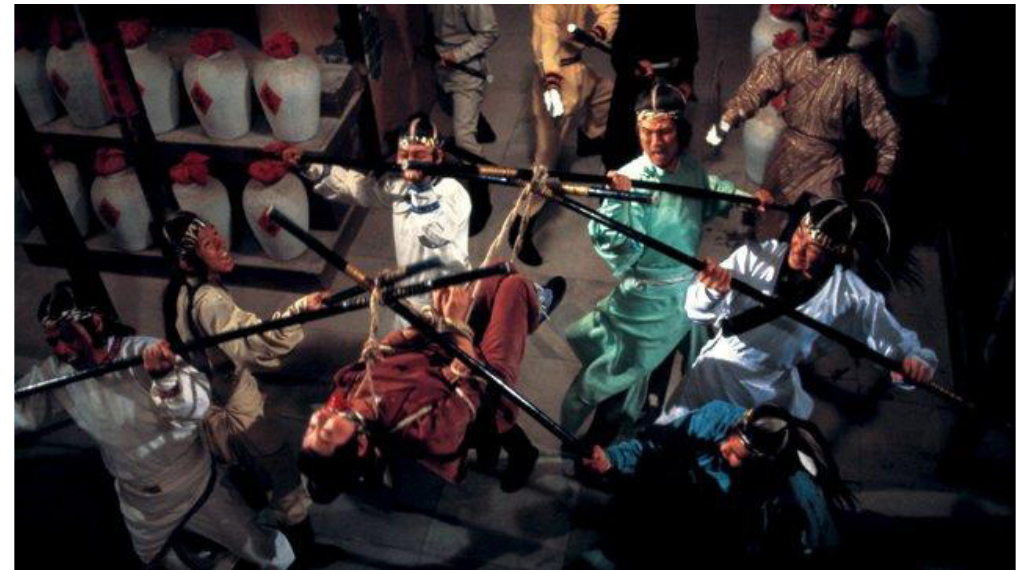
Figure 5. Eighth Yang Sister captured by her enemies after a